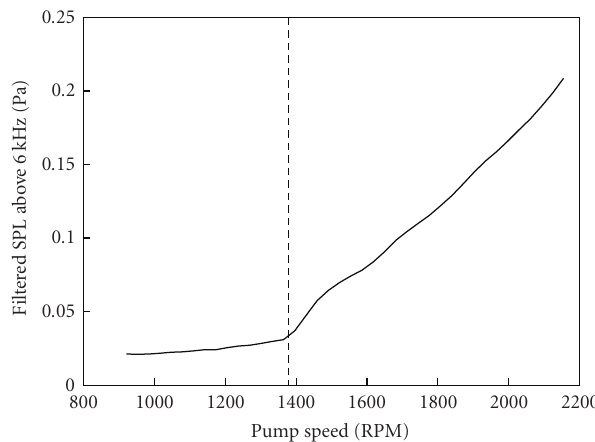
Figure 2: Filtered SPL versus pump speed for an automotive torque converter operating at stall; vertical dashed line indicates pump speed at onset of cavitation.